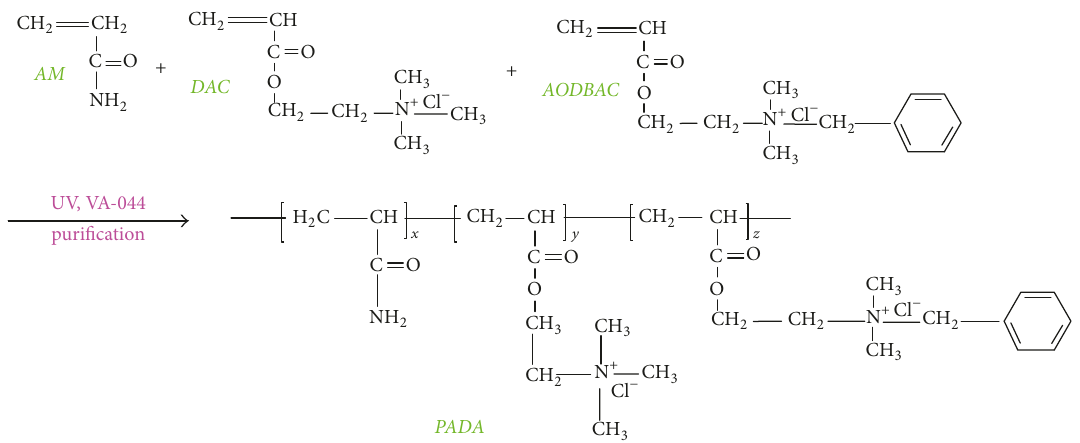
Figure 1: The possible reaction scheme for synthesis of PADA.